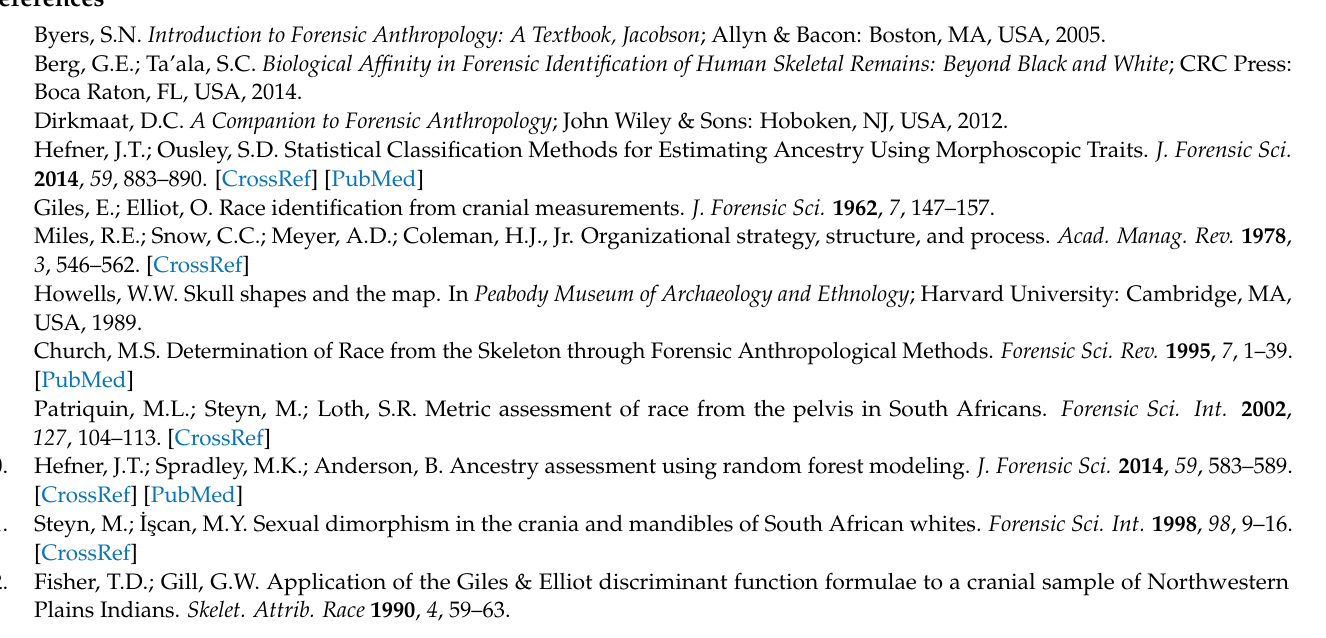
Table S2: Error Test